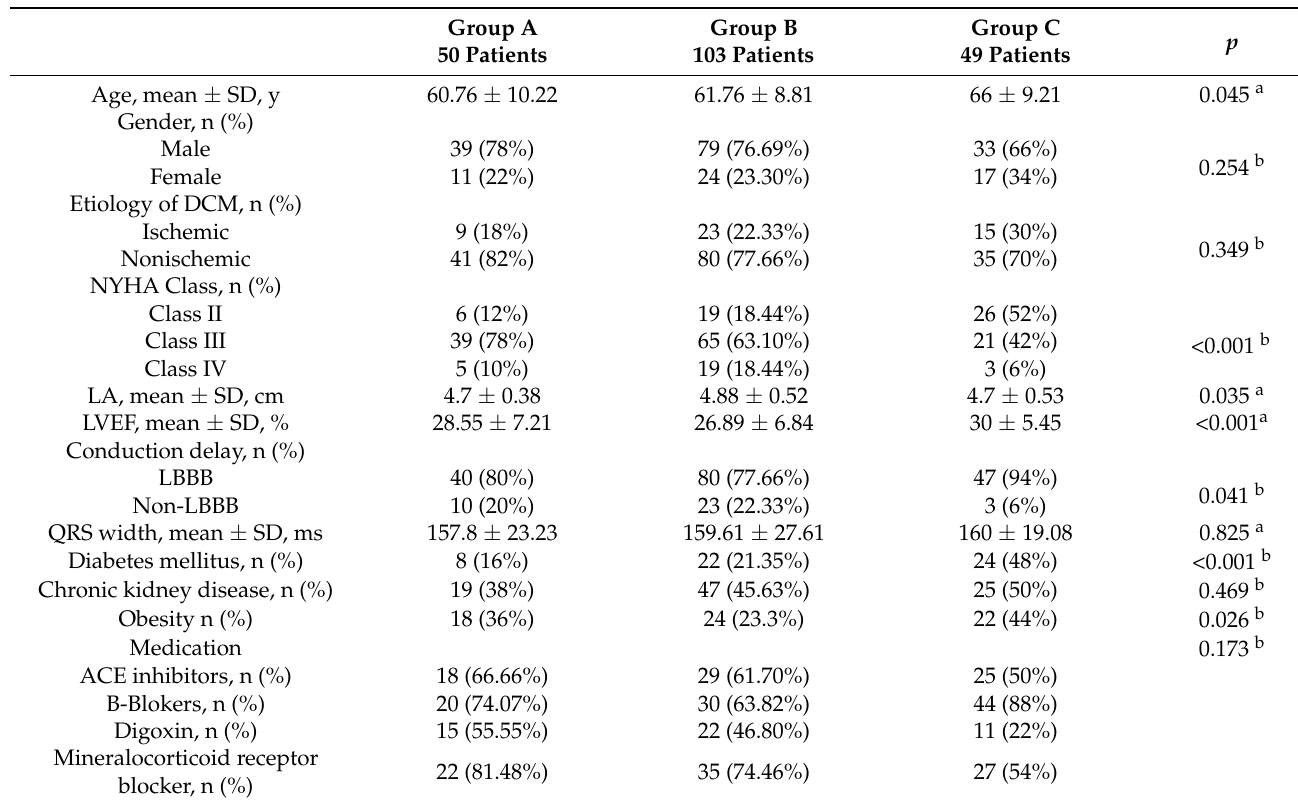
Table 1. Patient and device-related characteristics at the moment of intervention. Group